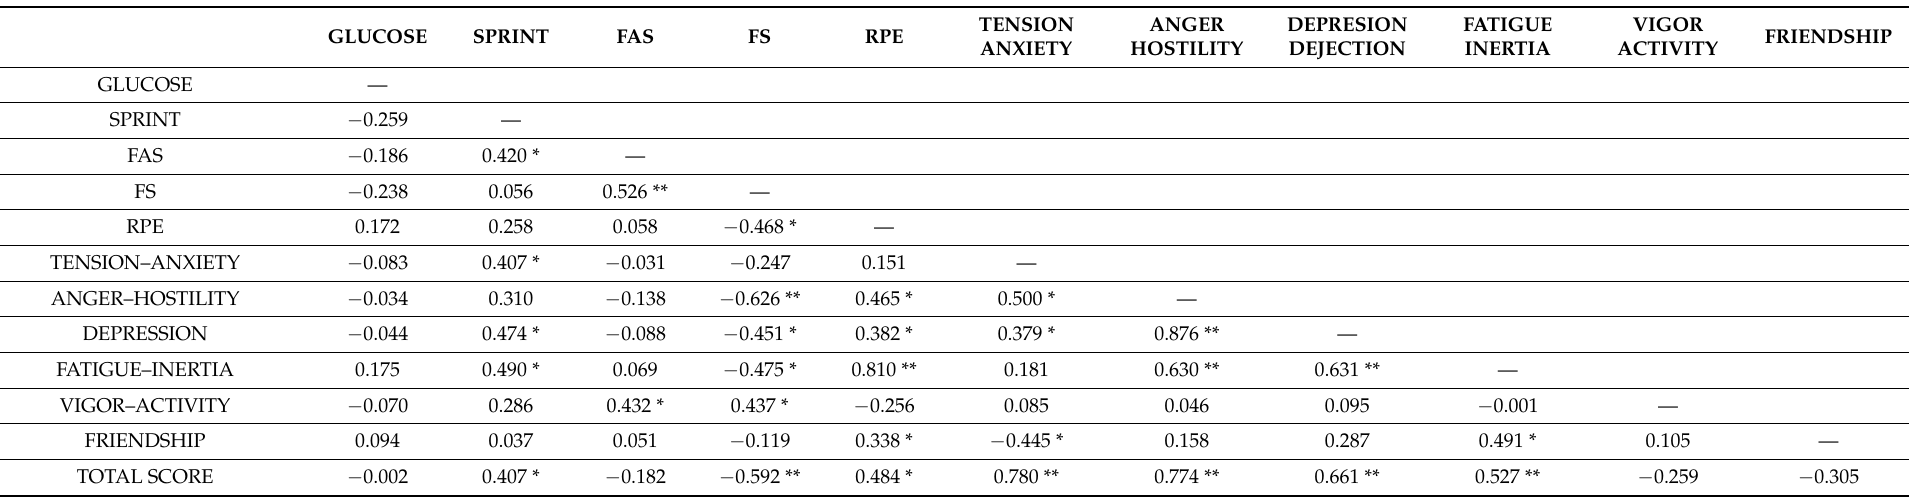
Table 3. Correlations between